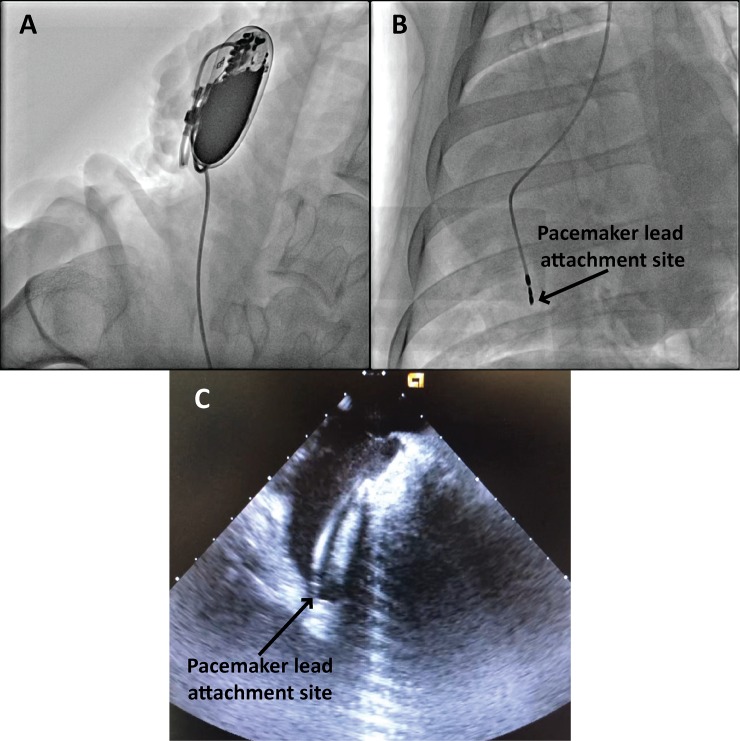
Representative fluoroscopy and ICE confirm anatomical location of the ventricular leads in the RV apex.(A) Fluoroscopic image demonstrating the anatomical location of the pacemaker device in the subcutaneous pocket. (B) Fluoroscopic image showing ventricular lead in the RV apex. (C) ICE image confirming position of the same ventricular lead in the RV apex.